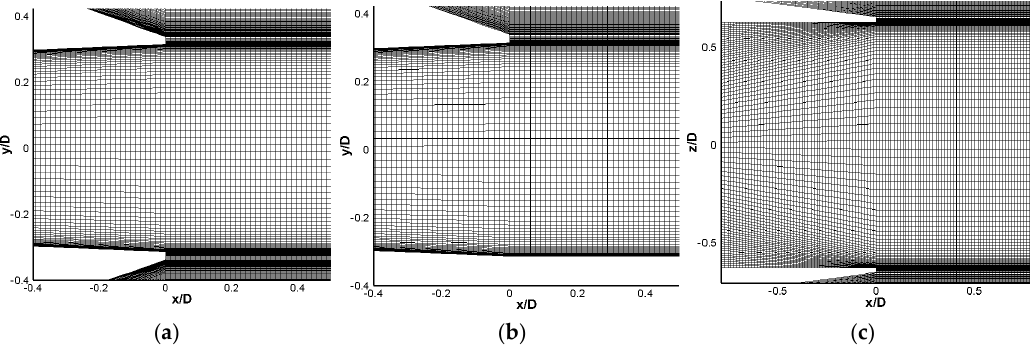
Figure 22. Computational grid near the nozzle exit. ( a ) Baseline case minor plane, ( b ) Shielded case minor plane, ( c ) Both baseline and shielded cases major plane.